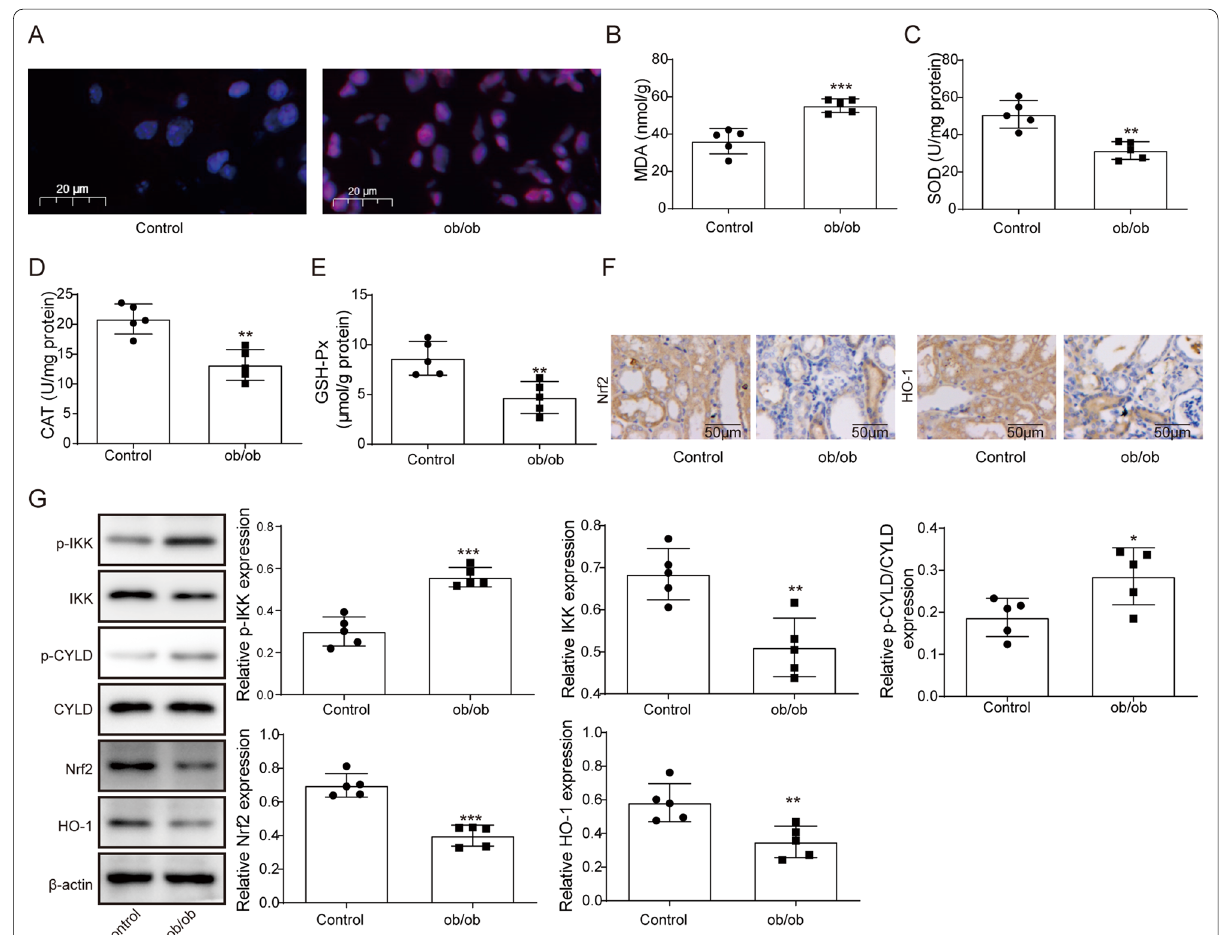
Fig. 2 Oxidative stress injury was observed in kidney tissues of ORN model mice. A The production of ROS in the kidneys of ORN model mice and control mice was measured using DHE staining. B – E MAD level, SOD activity, CAT activity and GSH‑Px activity were measured in mouse kidneys. F Representative IHC staining of Nrf2 and HO‑1 in mouse kidneys. G Western blot analysis of p‑IKK, IKK, p‑CYLD, CYLD, Nrf2 and HO‑1 expression in mouse kidneys. ORN, obesity‑related nephropathy; ROS, reactive oxygen species; DHE, dihydroethidium; MAD, malondialdehyde; SOD, superoxide dismutase; CAT, catalase; GSH‑Px, glutathione peroxidase; IHC, immunohistochemistry; Nrf2, NF‑E2‑related factor 2; HO‑1, haem oxygenase 1; IKK, IκB kinase; CYLD, cylindromatosis. Significance was assessed by a Student’s t test. The experimental data are shown as the mean *P < 0.05, **P < 0.01, ***P <